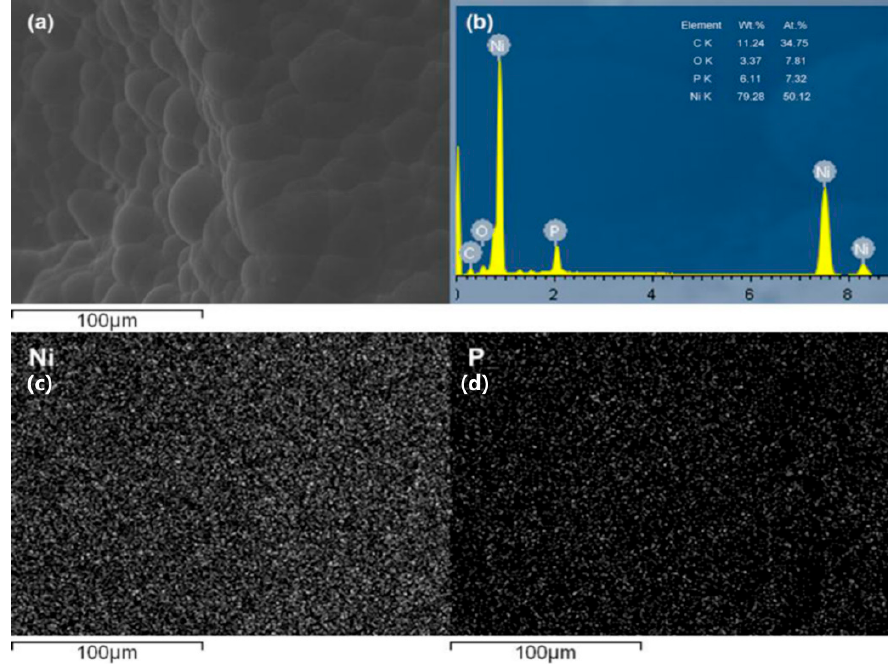
Figure 3. EDS analysis on the surface of the AZ91D hybrid foams: ( a ) SEM image. ( b ) element compositions and content. ( c ) distribution of Ni element. ( d ) distribution of P element.